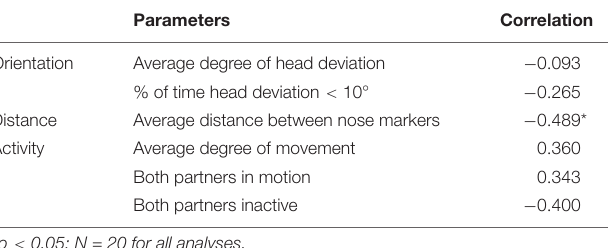
TABLE 3 | Correlations between rapport ratings and the dyadic aggregate measures.